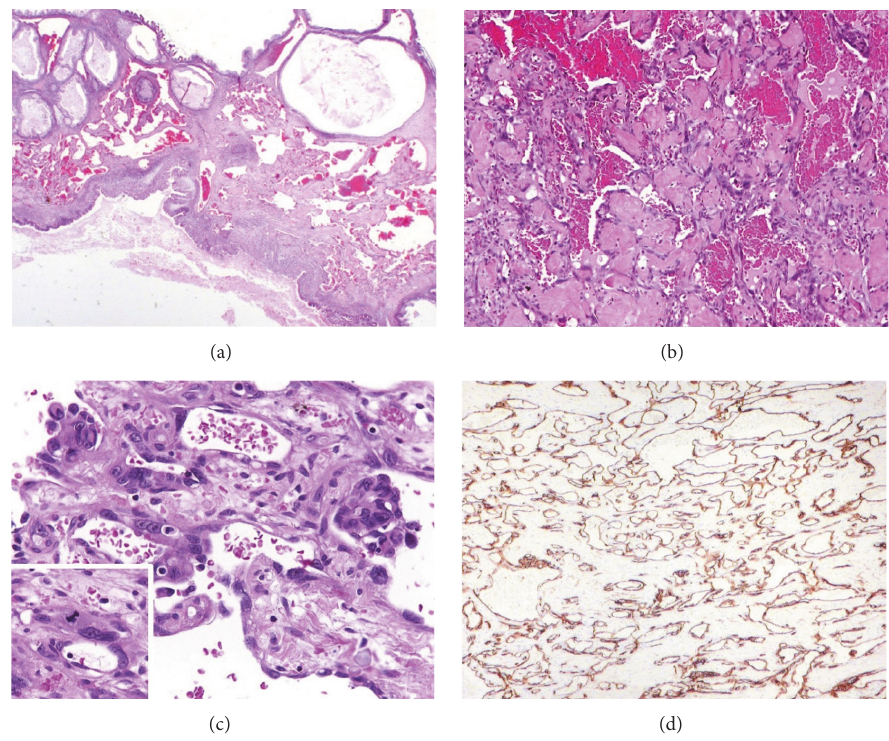
Figure 2: Angiosarcoma in mucinous tumor. (a) Dissecting growth of ectatic vascular channels in a septum between mucinous borderline locules (H&E stain: × 10). (b) Endothelial lining with marked nuclear atypia (H&E stain: × 100). (c) Focal endothelial tufting and mitotic activity (inset) (H&E stain: × 400). (d) Diffuse immunoexpression of CD31 (CD31 immunostain: × 40).